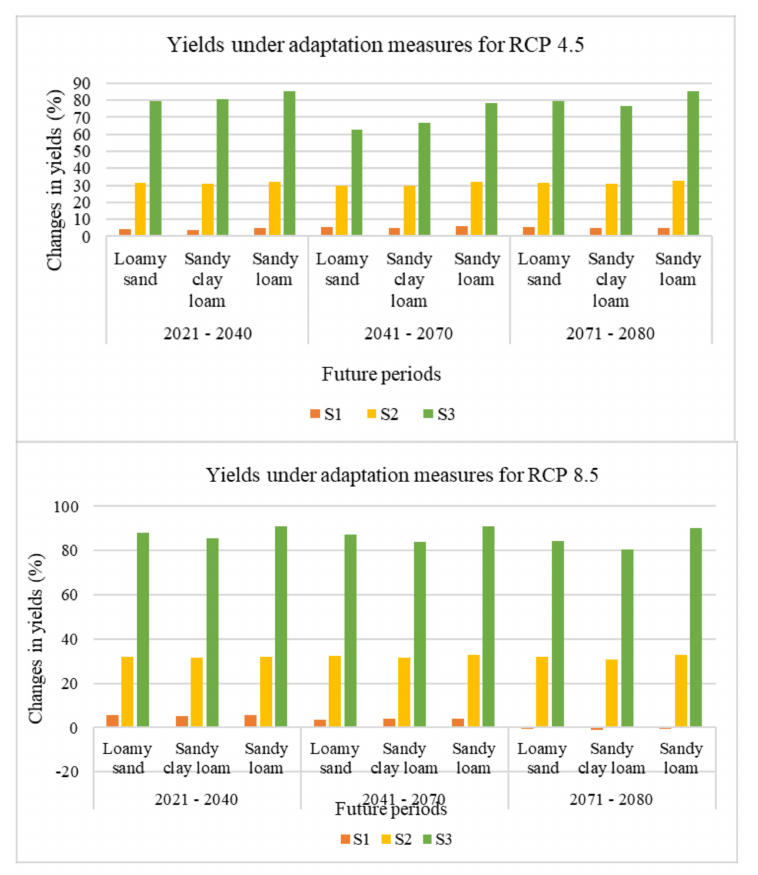
Figure 13. E ff ects of supplemental irrigation (S1), soil fertility at nitrogen value of 90 kg / ha (S2) and soil fertility at nitrogen value of 120 kg / ha (S3) on rainfed yields under RCP 4.5 and RCP